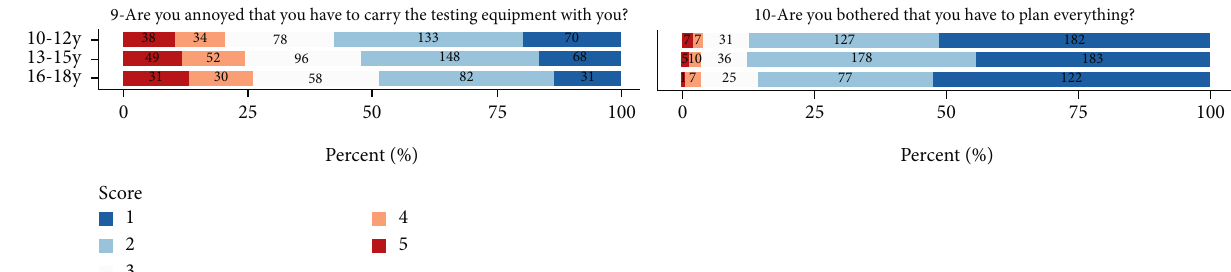
Figure 3: Stacked box plot with responses to items 1 – 10 for children aged 10 – 12, 13-15, and 16-18 years. Valid N is marked in the bars. Blue re fl ects a higher quality of